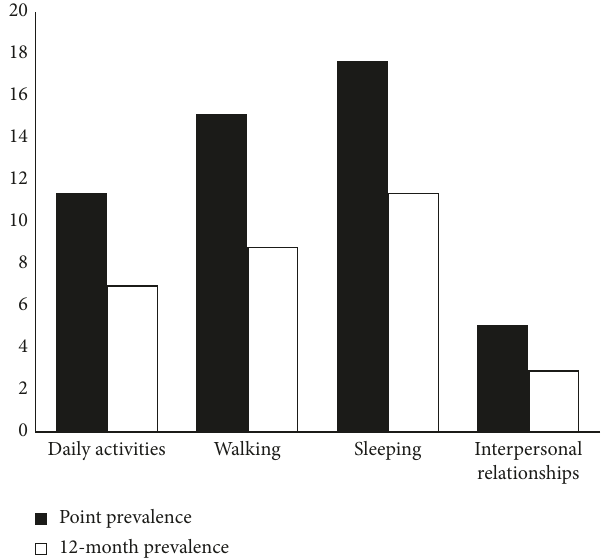
Figure 2: The impact of low back pain on medical students’ ev- eryday functioning.